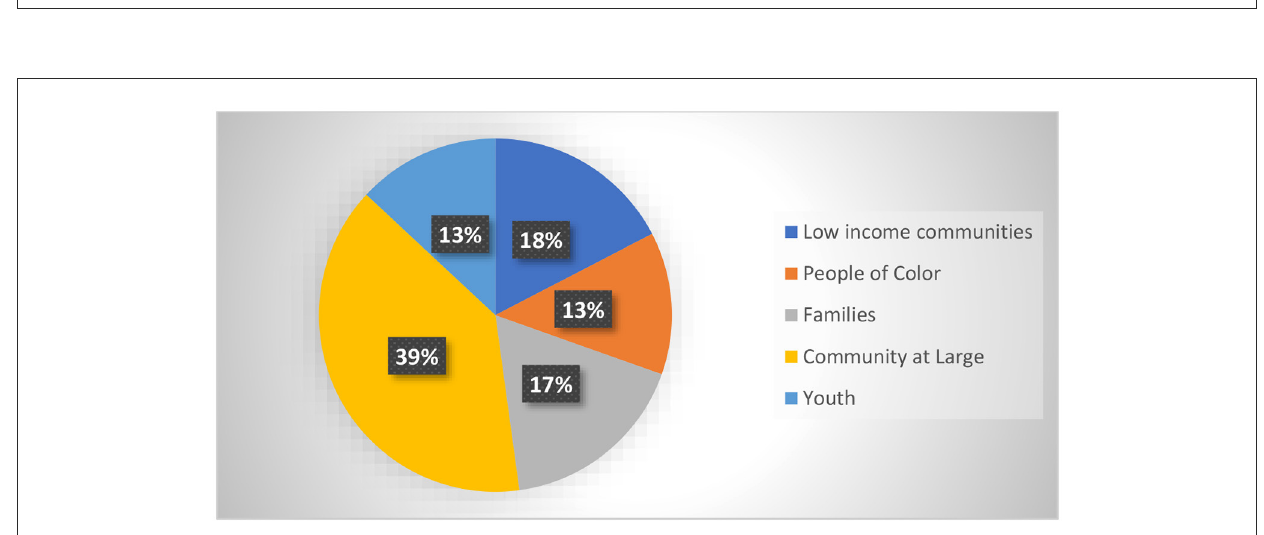
FIGURE5 The most desired audiences for interviewed and web-researched organizations in the Hudson Valley. Source: Interviews and website analysis.